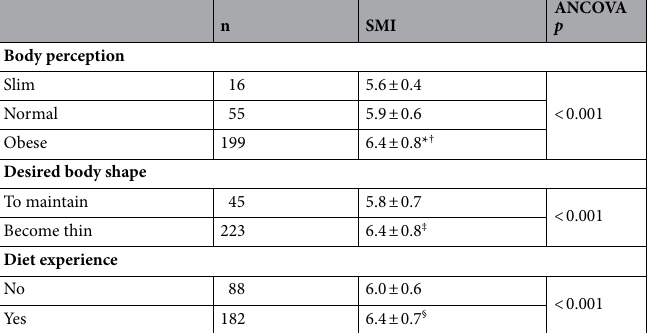
Table 6. Results of analysis of covariance. Analysis of covariance was used for each comparison of body perception, desired body shape, or diet experience. Bonferroni method or unpaired t test was used for post- hoc test. ANCOVA: analysis of covariance, SMI: skeletal muscle mass index. *Significantly different from “slim” ( p < 0.05). † Significantly different from “normal” ( p < 0.05). ‡ Significantly different from “To maintain” ( p < 0.05). § Significantly different from “No” ( p <